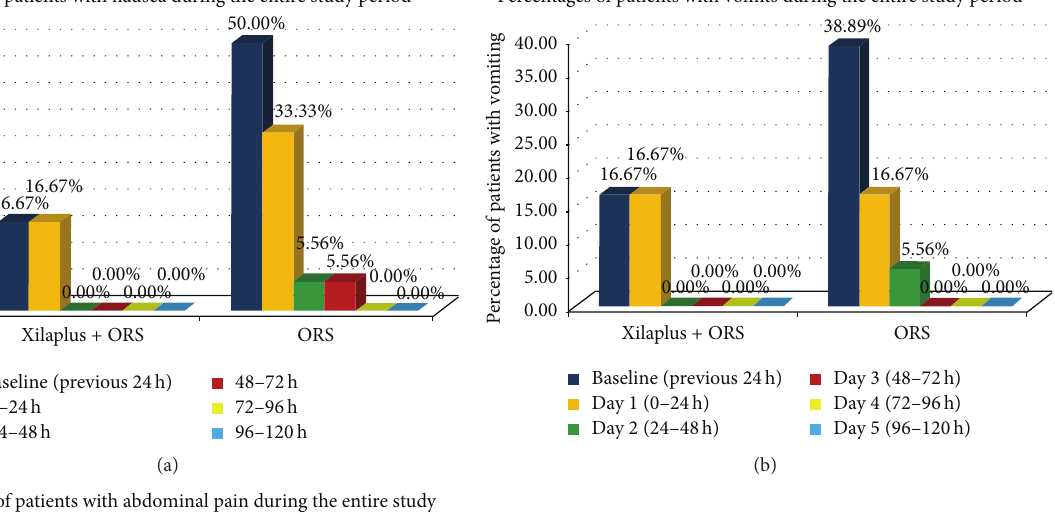
Percentages of patients with flatulence during the entire study period